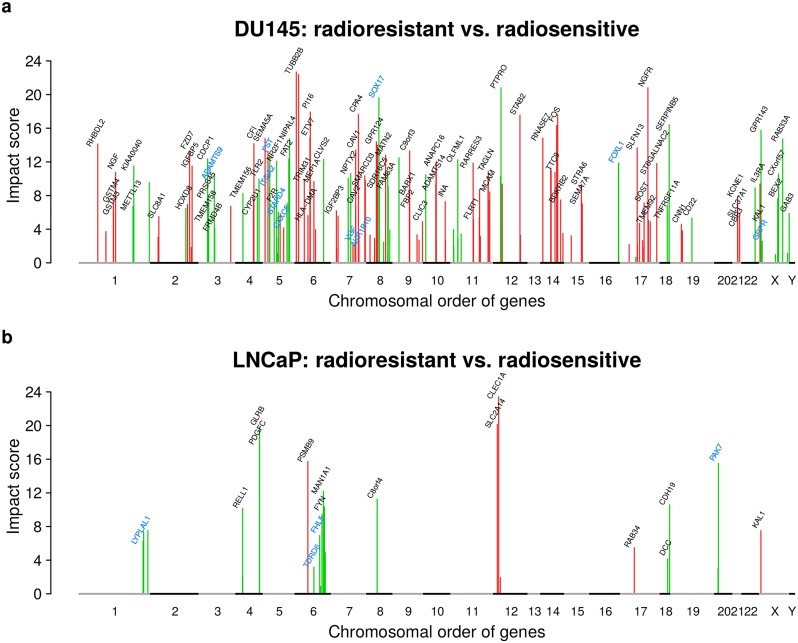
Impacts of potential radioresistance driver genes on known radioresistance markers.Impacts of differentially expressed genes with directly underlying copy number alterations in radioresistant DU145 (a) and radioresistant LNCaP (b) on known markers of radioresistance. The impact score represents the log10-ratio of the gene-specific impact on known radioresistance marker genes comparing the impact score reached for the prostate cancer specific network to the average impact score obtained under 10 random networks of same complexity (degree-preserving network permutations). Impact scores of genes with significantly greater impacts under the original network (q < 0.01) are shown by colored peaks (green: deleted and underexpressed; red: amplified and overexpressed for radioresistant vs. radiosensitive). The majority of gene names are shown. See S5 Table for names of all putative high impact genes. High impact genes that enabled a separation of TCGA prostate cancer patients into early and late relapse groups (Fig 5, S5 Fig) are highlighted in blue.